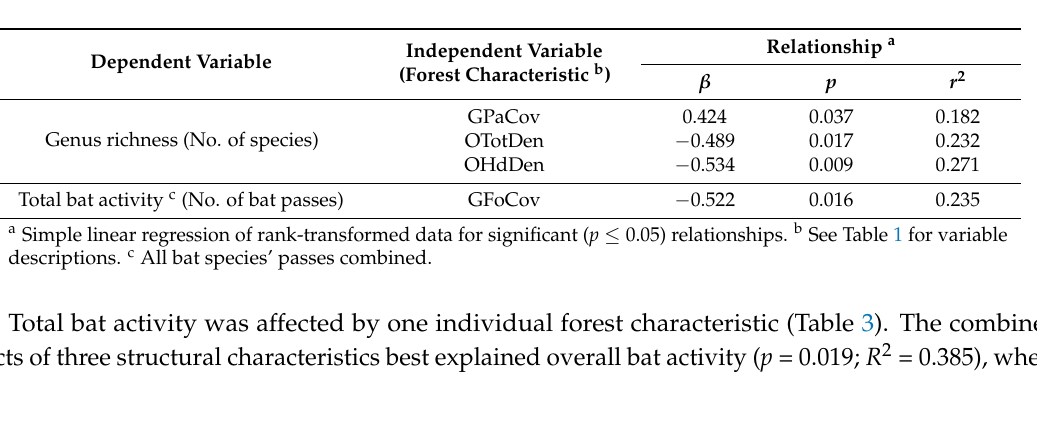
Table 3. Bat genus richness and total bat activity relationships with forest structure and composition in the Chiquibul Forest Reserve (CFR), Belize, Central America, in summer